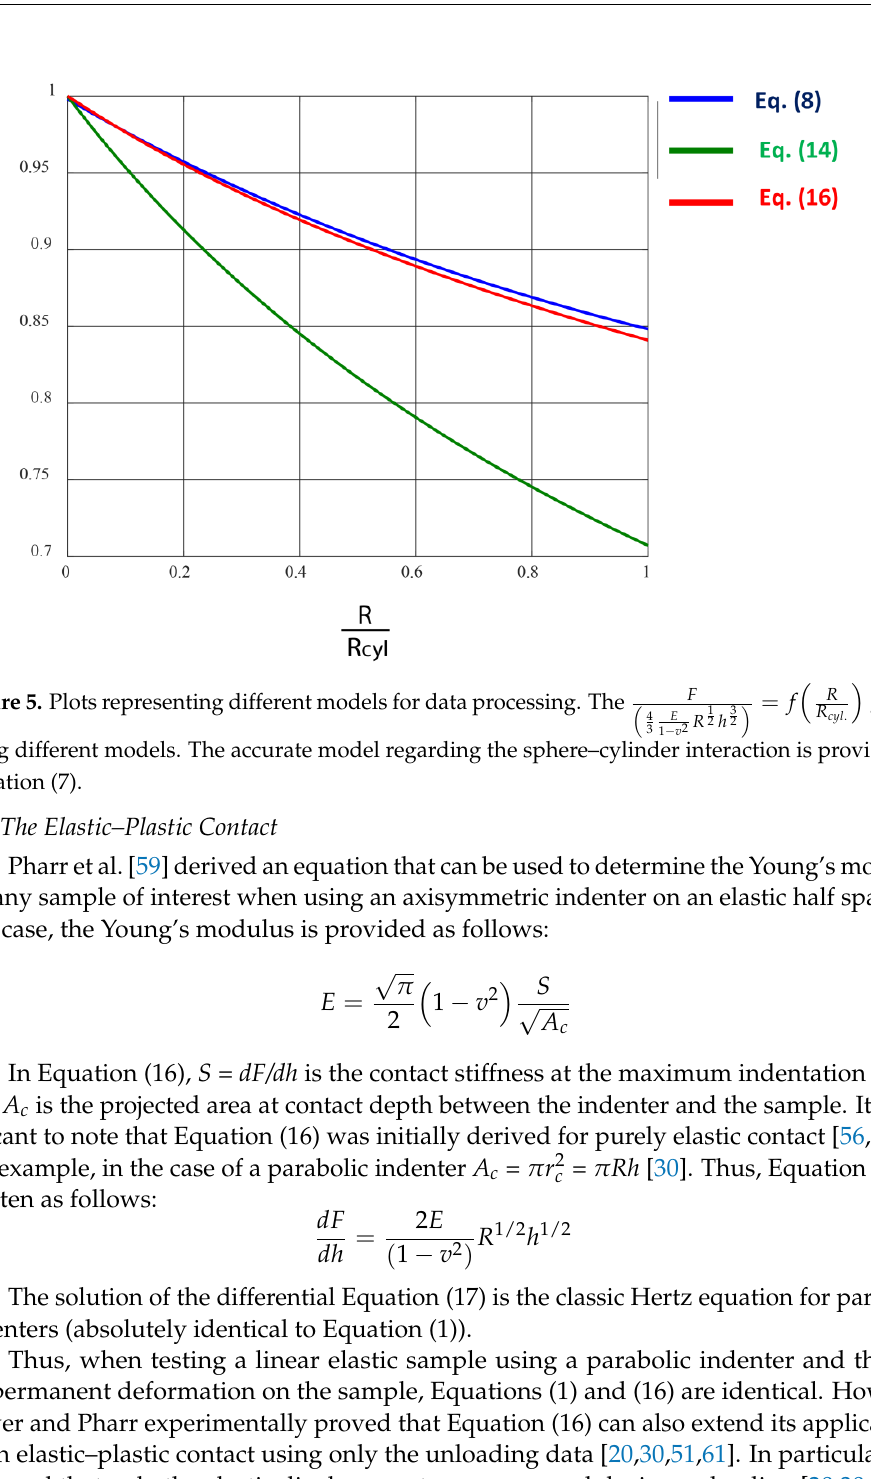
(cid:17) (cid:16) R graphs = 𝑓 ( 𝑅 ) graphs (cid:17) = f R cyl . 1 3 E 4 R 1 2 h 3 2 𝑅 𝑐𝑦𝑙. 𝐸 ( 4 3 2 ℎ 2 ) 1 − v 2 1−𝑣2 𝑅 3